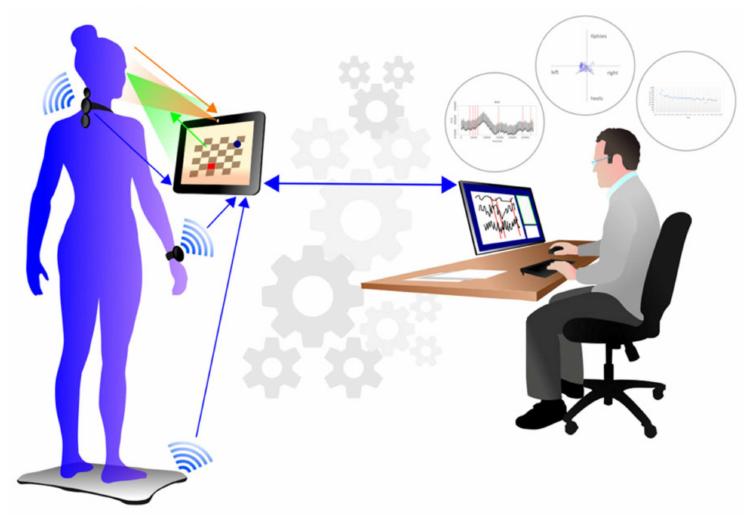
Figure 1. Scheme of the use of wearables when using medical device